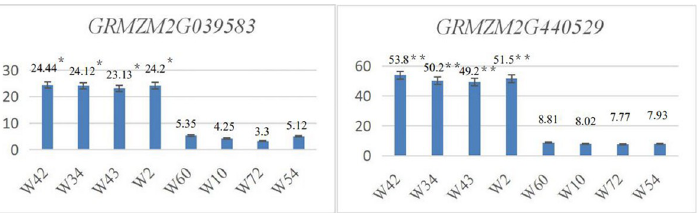
Fig 6. GRMZM2G039583 and GRMZM2G440529 qRT-PCR expression levels in the GWAS population.